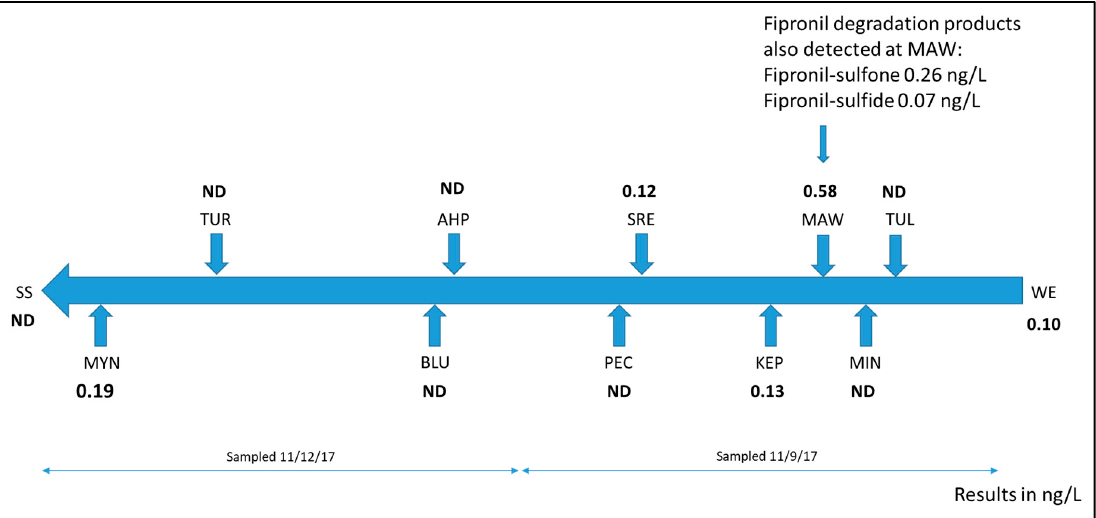
Figure 1. Fipronil and fipronil degradation product detections (ng/L) in the Klamath River and selected tributaries during November 2017.